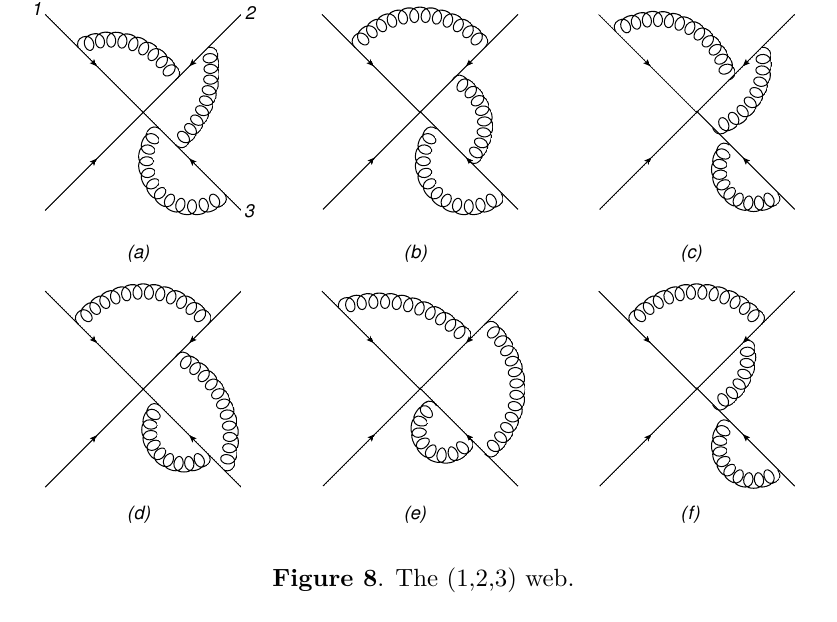
Figure 8 . The (1,2,3)